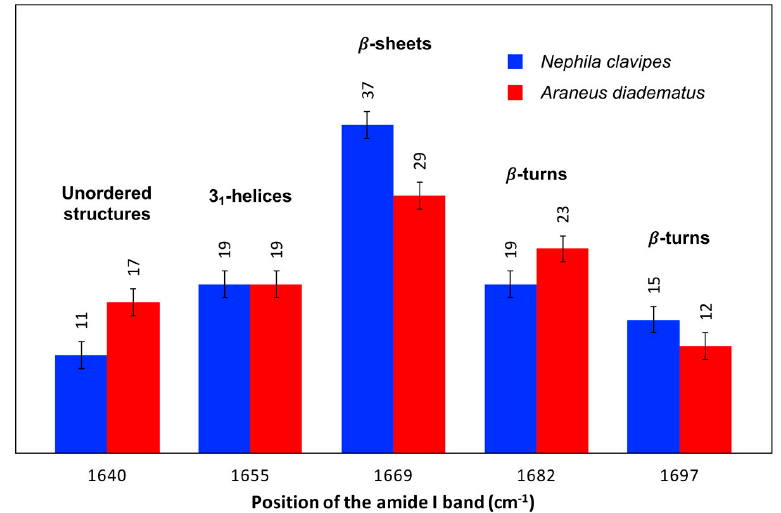
Figure 5. Relative band areas of the different amide I components of Nephila clavipes and Araneus diadematus fibers. The approximate error on the secondary structure content due to curve-fitting is ±3% and is represented by the error bars on the figure.